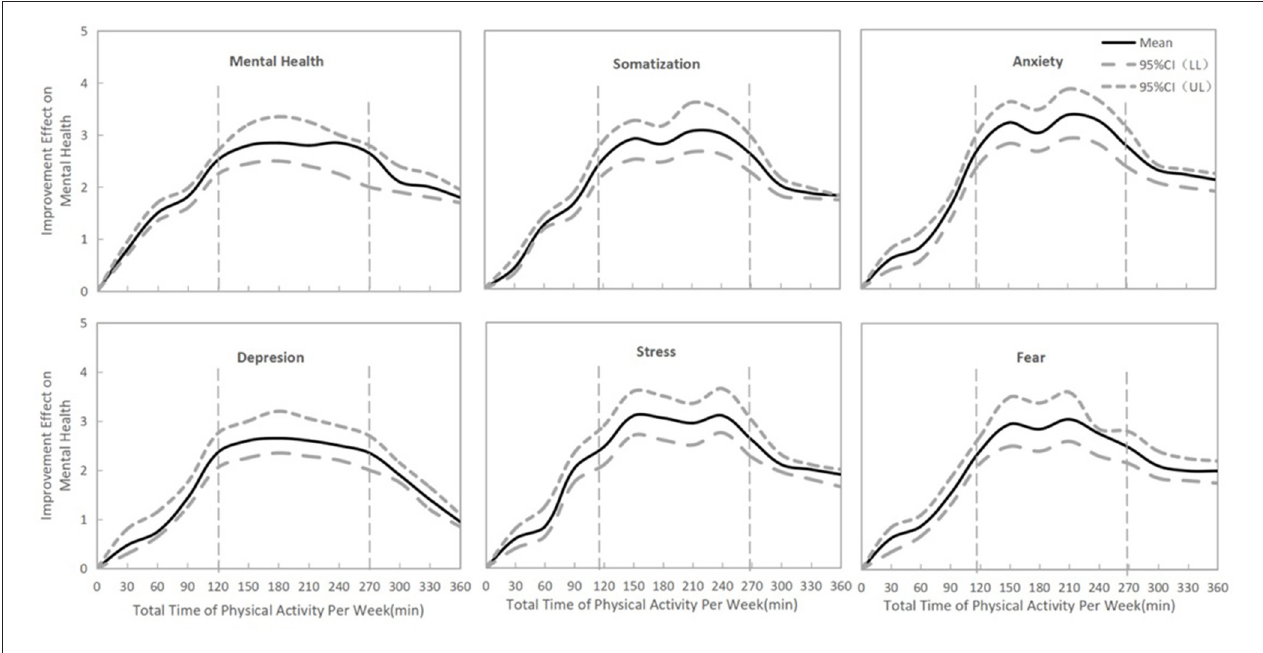
FIGURE 8 | The association between mental health improvement and weekly total physical